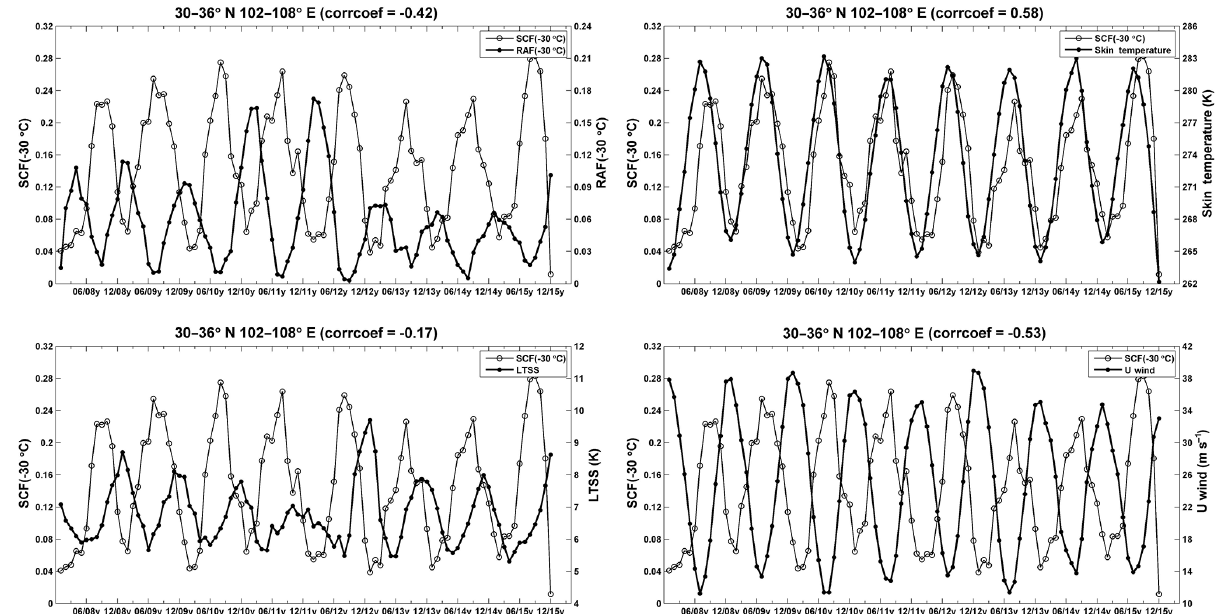
Figure 8. Time series plots of SCFs, meteorological parameters and RAFs of IN aerosol at − 30 ◦ C isotherm over the central China (102– 108 ◦ E, 30–36 ◦ N). Each line in every subplot corresponds to a time series of different variables after 5 months of smoothing. The coefficients (at the 90% confidence level) in subplots represent the temporal correlation between the original SCFs series and meteorological parameters (or RAFs). The confidence values (i.e., p value) are provided only when the confidence level of the temporal correlation between variables is less than 90%.